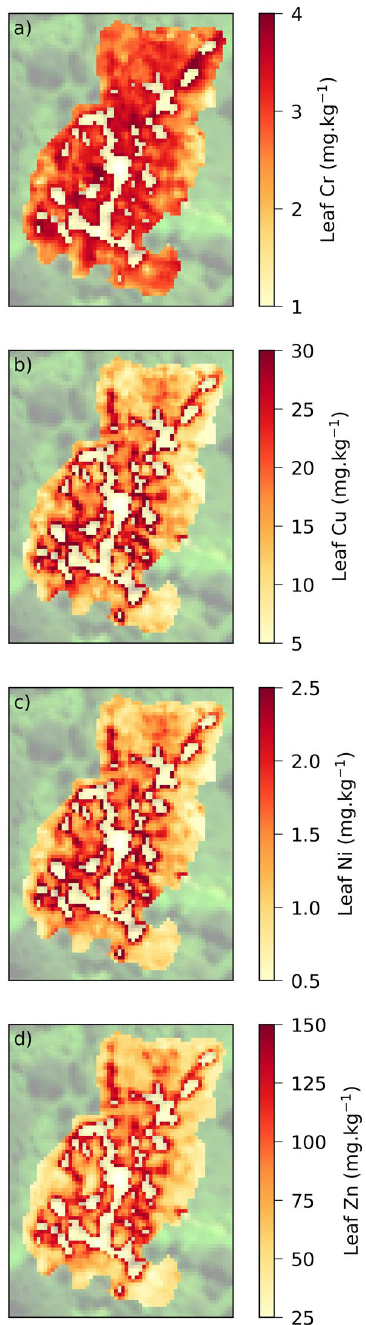
airborne hyperspectral image, at 1 m spatial